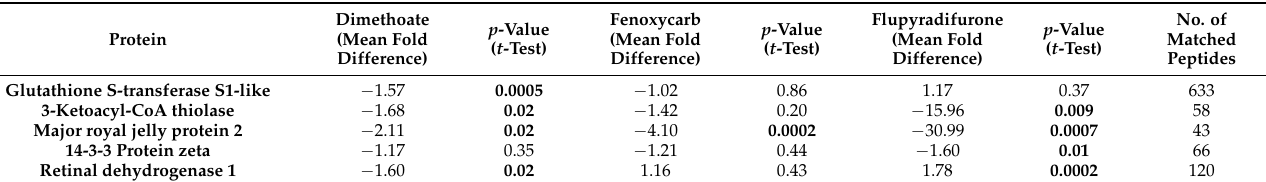
Table 2. All identified significantly regulated proteins of the three different insecticide treatment groups. Significant changes in relation to their respective solvent controls (CS) are marked in bold.